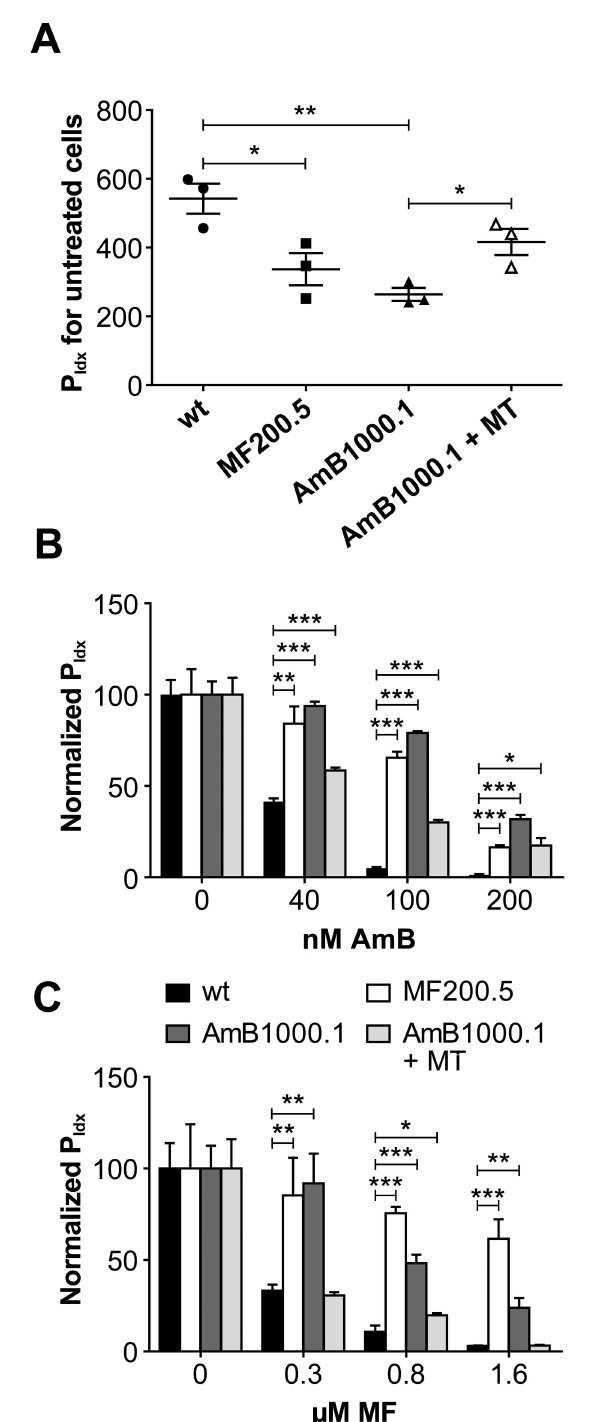
Fig 2. Infectivity of the different strains in THP-1-derived macrophages and intracellular drug resistance. (A) Infectivity of the different studied strains after 96h post-infection in the absence of drug treatment. The P Idx represents the percentage of infected cells multipliedby the mean numberof parasites per cell. Histogram showingnormalized P Idx dose-response effect after 96 h of expositionto increasing concentrations of AmB (B) and MF (C) for the strains studiedin (A). Normalization represents the percent reduction of the total parasiteburdencomparedto the non-treatedinfected control. Data are the mean ±